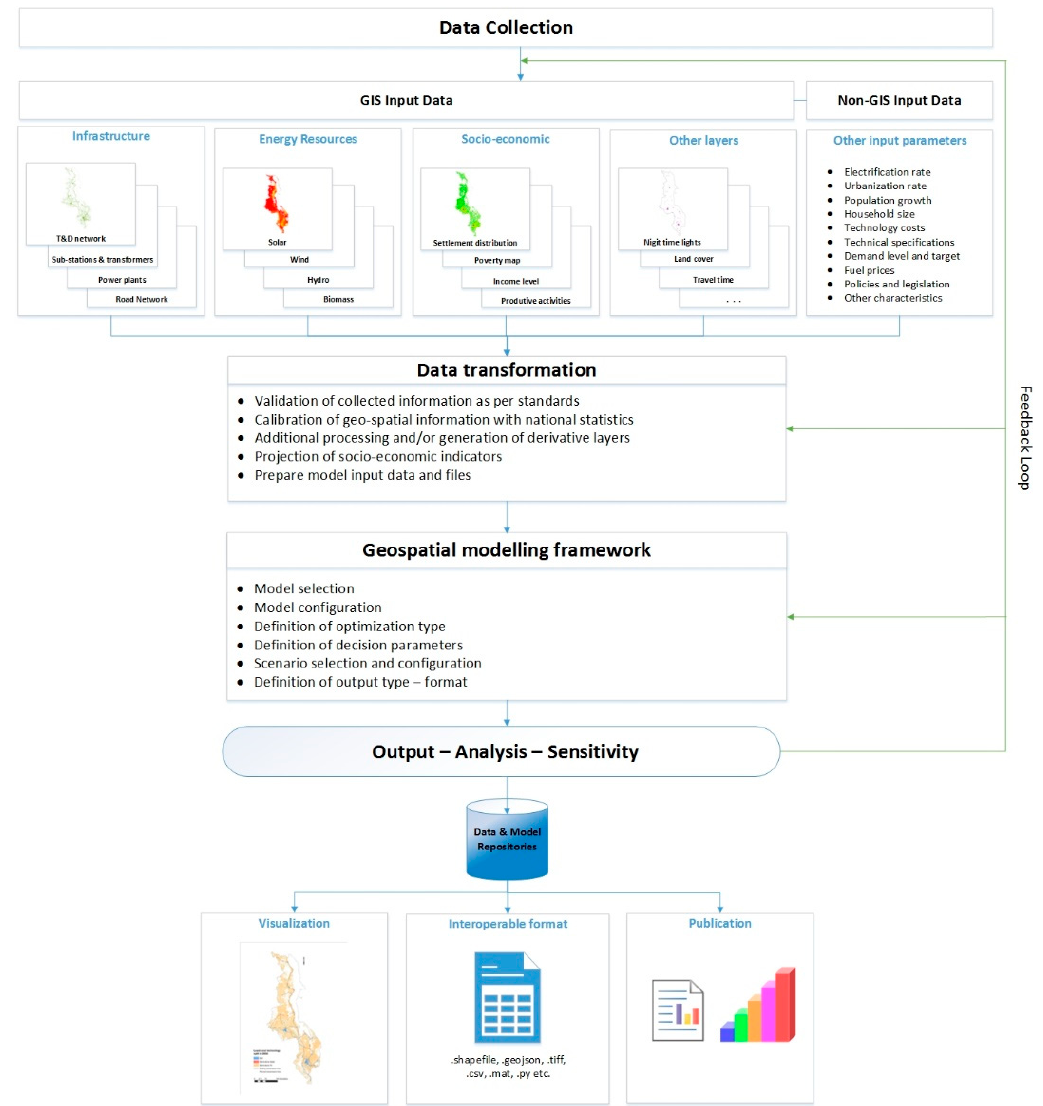
Figure 1. Conceptual flowchart of GIS -electrification modelling frameworks.